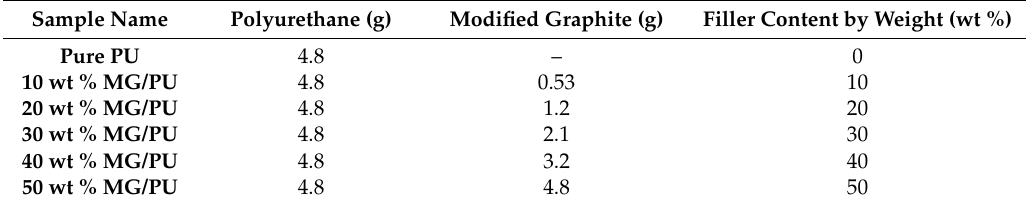
Table 1. Composition of modified-graphite/polyurethane (MG/PU) composite films.